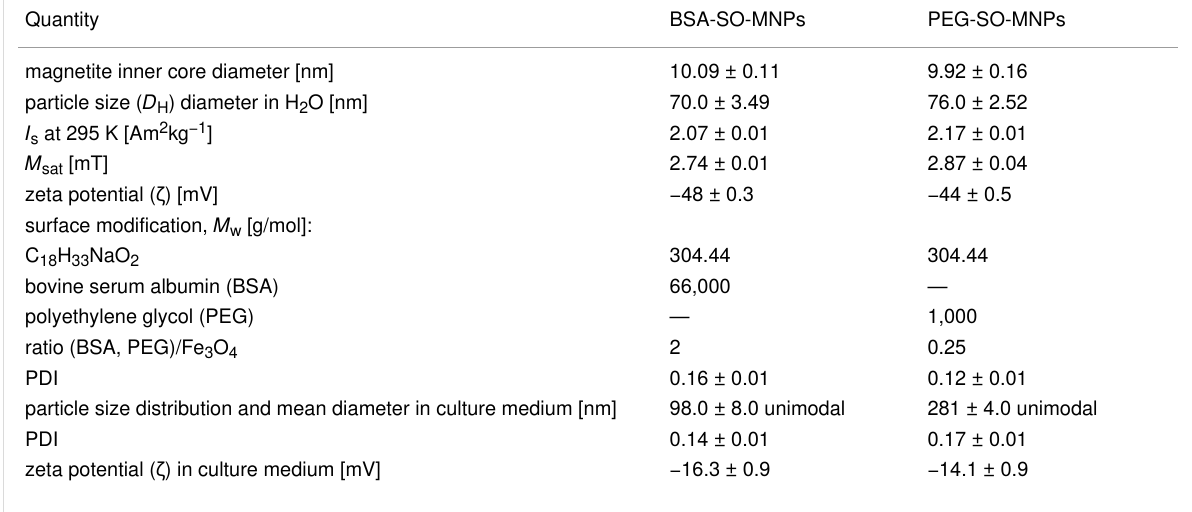
Table 1: Basic physicochemical properties of surface-modified magnetite